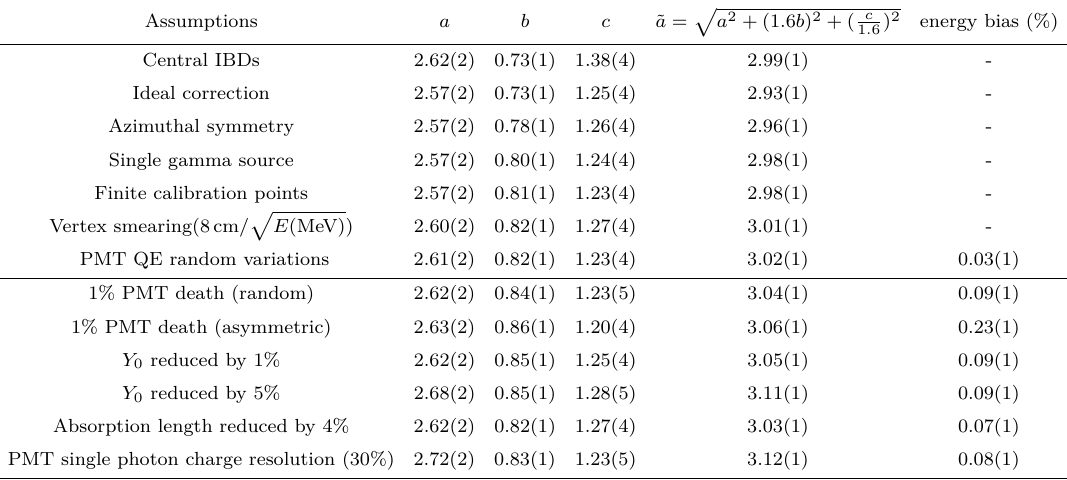
Table 3 . Energy resolution after sequential downgrade from the ideal to realistic calibration, considering all assumptions from section 3.1 to section 3.9. Values in parentheses indicate fitting uncertainties, and the uncertainty of ˜ a has taken into account the correlations in a , b and c . Each row from “Azimuthal symmetry” to “PMT QE random variations” indicates cumulative effects down to this row. This gives an ˜ a of 3.02% for nominal JUNO situation. Each line starting from “1% PMT death (random)” represents an individual imperfection of the CD, which also includes effects up to the double-line (nominal ˜ a